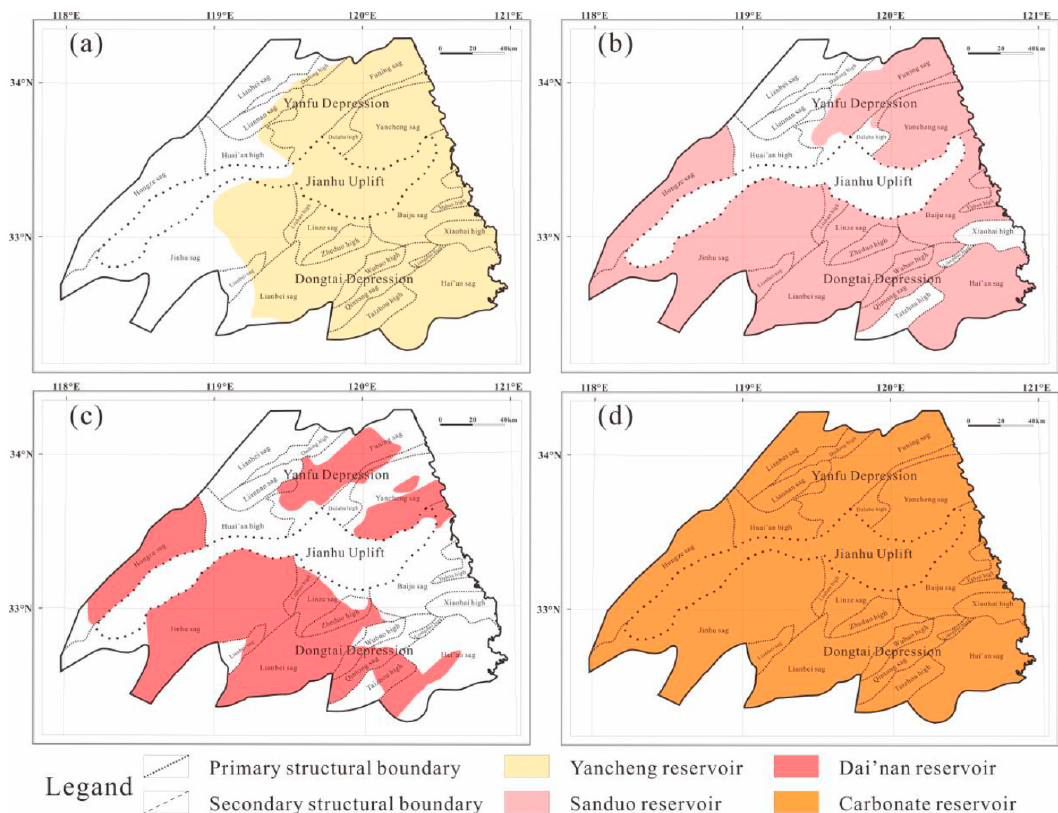
Figure 3. Distribution of Cenozoic sandstone thermal reservoirs and carbonate thermal reservoirs in the North Jiangsu Basin. ( a ) Yancheng reservoir; ( b ) Sanduo reservoir; ( c ) Dai’nan reservoir; ( d ) Carbonate reservoir.